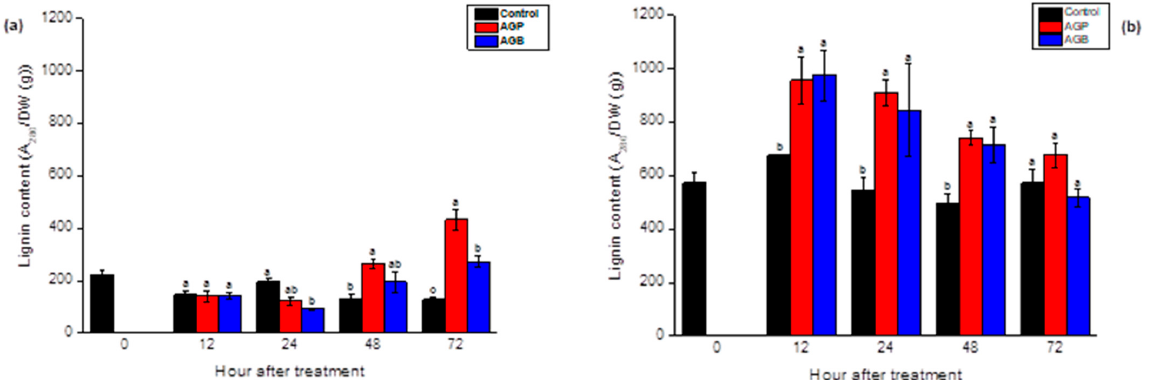
Figure 9. Lignin content in the leaves ( a ) and the roots ( b ) of tomato seedlings after foliar spray (20 mL) of AGB and AGP fractions (1 g/L). Each value is the mean of four repetitions ± SE. The letters (a, b, c) indicate significant differences between treatments (Control, AGB, and AGP) in each point time, using the Tukey–HSD test, at ( p < 0.05). Treatments presented with the same letter are not significantly different